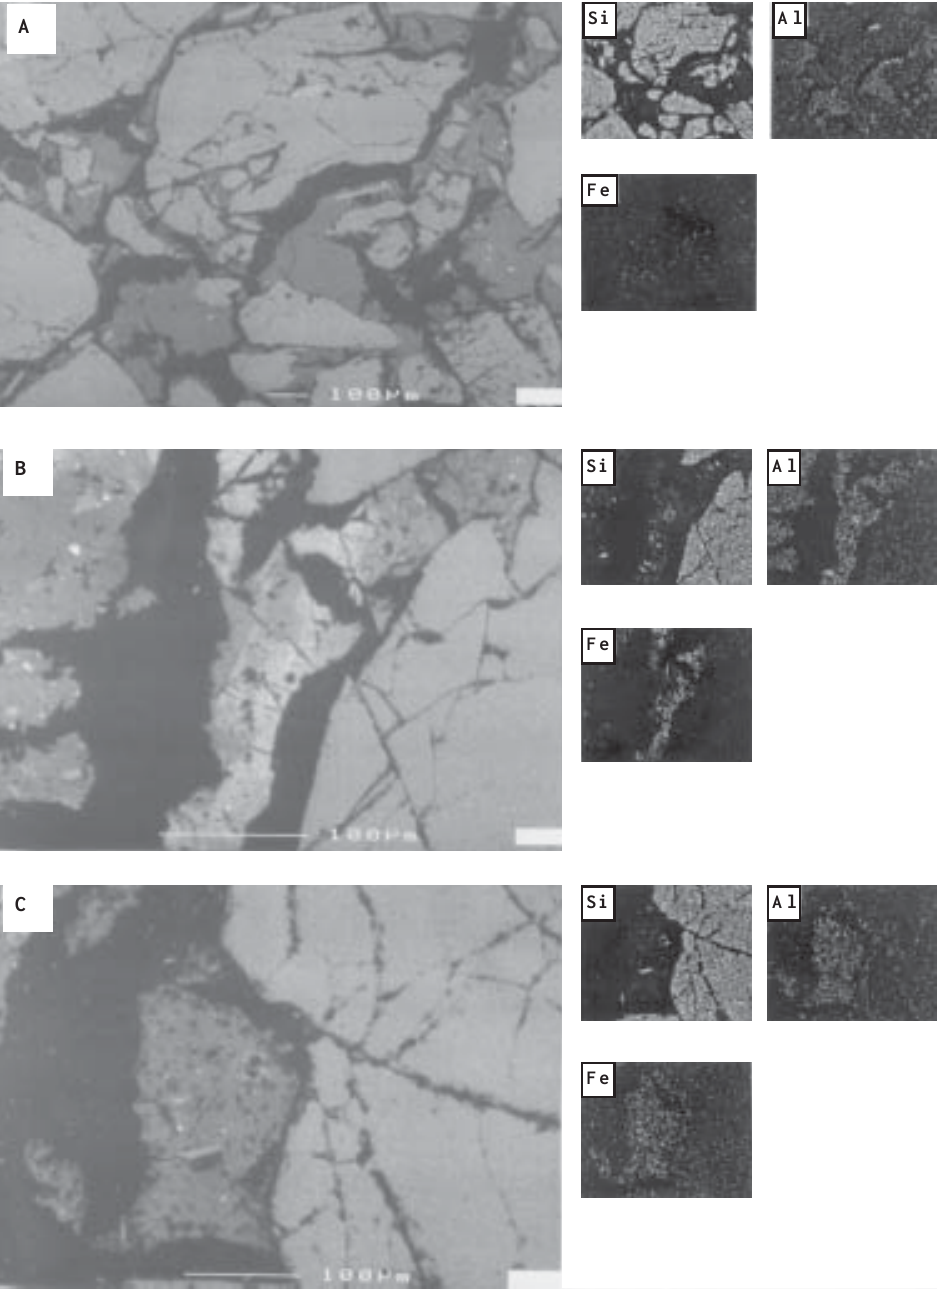
Figura 4. Fotomicrografias em retroespalhamento eletrônico (backscattering) em MEV e respectivos mapas microquímicos de EDS para Si, Al e Fe, em algumas feições selecionadas nos horizontes Bs (fotos A e B) e Bh (foto C) do Espodossolo (P3). Os dados analíticos de EDS do plasma estão reportados no quadro